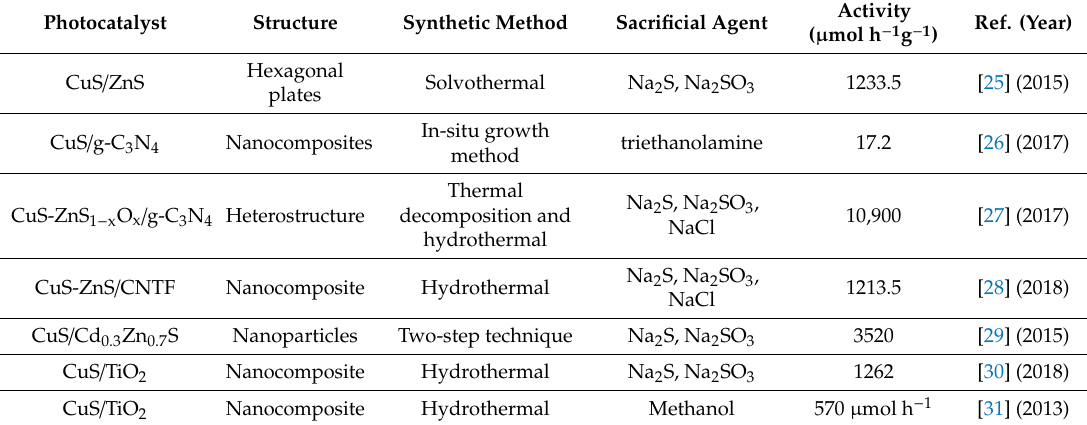
Table 2. Photocatalytic activity of copper sulfide as the